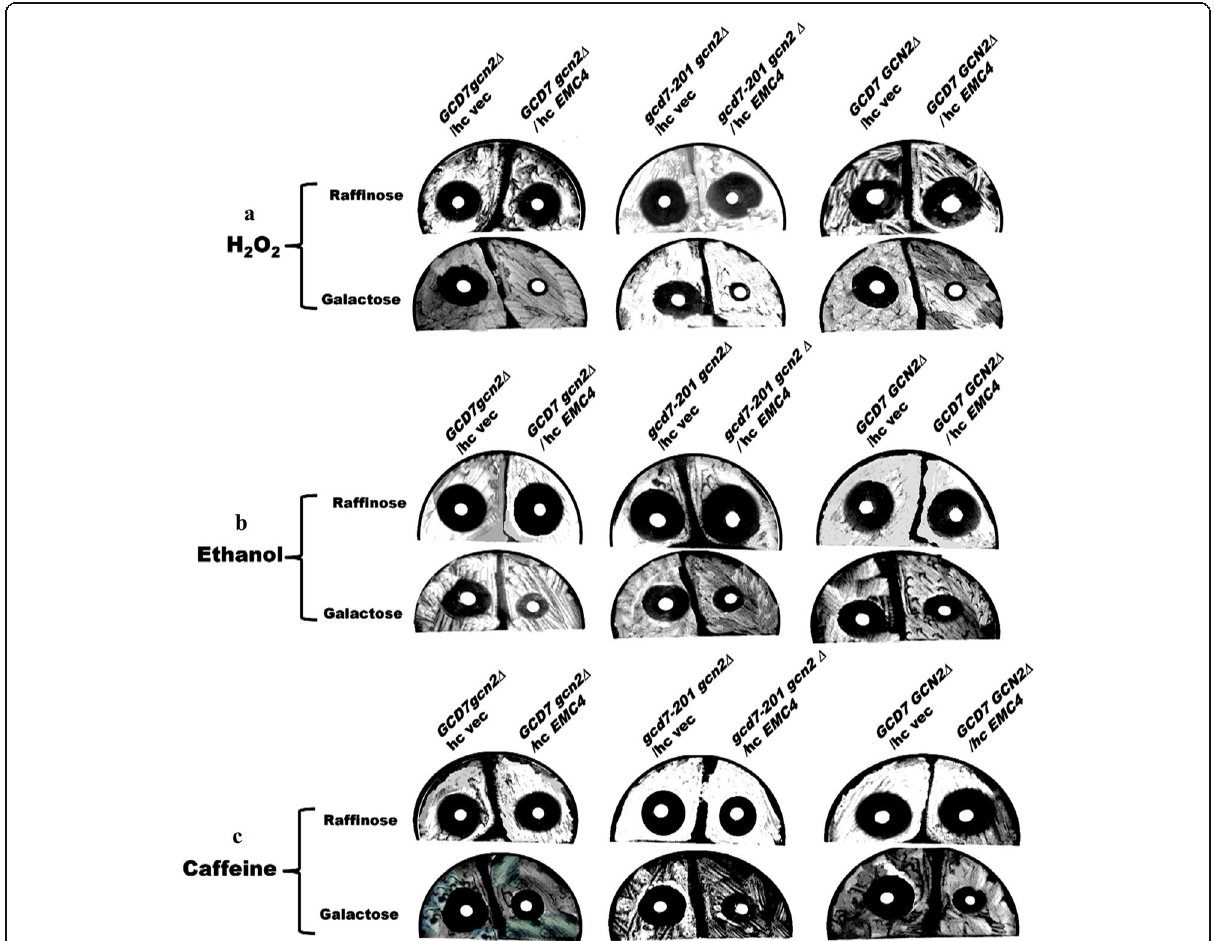
Fig. 3 Halo assay to test the effect of H 2 O 2 , ethanol, and caffeine on the growth of eIF2B mutants. Hydrogen peroxide, ethanol, and caffeine halo assays were performed with gcd7-201 gcn2 Δ , GCD7 gcn2 Δ , and GCD7 GCN2 . S. cerevisiae strains harboring either the empty hc vector, pEG (KG), or the hc/ EMC4 gene expressing plasmid were spread on SC medium, containing filter disks soaked in ( a ) H 2 O 2 (4 mM), ( b) ethanol (10%), and ( c ) caffeine (30 mM) in the presence of either raffinose or galactose. The plates were incubated at 30 °C for 2 – 3